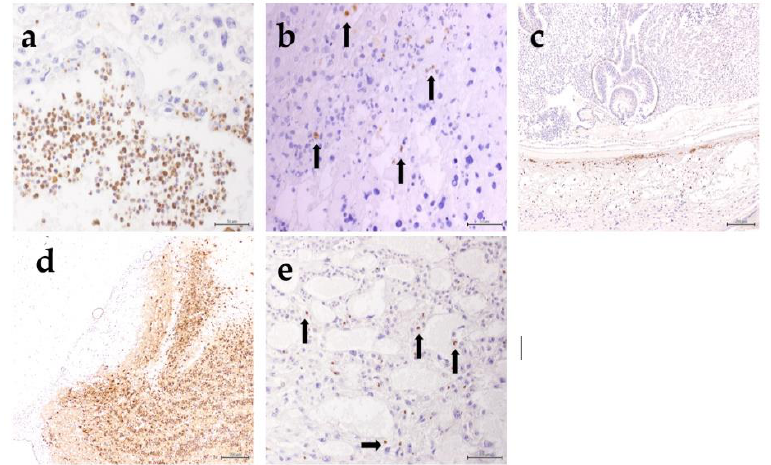
Figure 7. The viral antigen was detected in fetal tissue in group 2 at 6 dpi in mononuclear leukocytes occupying the maternal blood spaces in the thin decidua capsularis and basalis ( a ), degenerated trophoblast cells in the labyrinth and spongiotrophoblast layer ( b ), and leukocytes infiltrating the necrotic areas in the decidua capsularis, in contrast to the live fetal tissue ( c ). The antigen was also observed in the olfactory bulb ( d ) and lungs ( e ) of dams in group 2 at 6 dpi. On the 15th day of gestation, full birth fetuses had fully developed allanto-chorionic placentas composed of chorionic villi, degenerated labyrinthine, and trophospongium layers with a very thin vacuolated decidual layer.